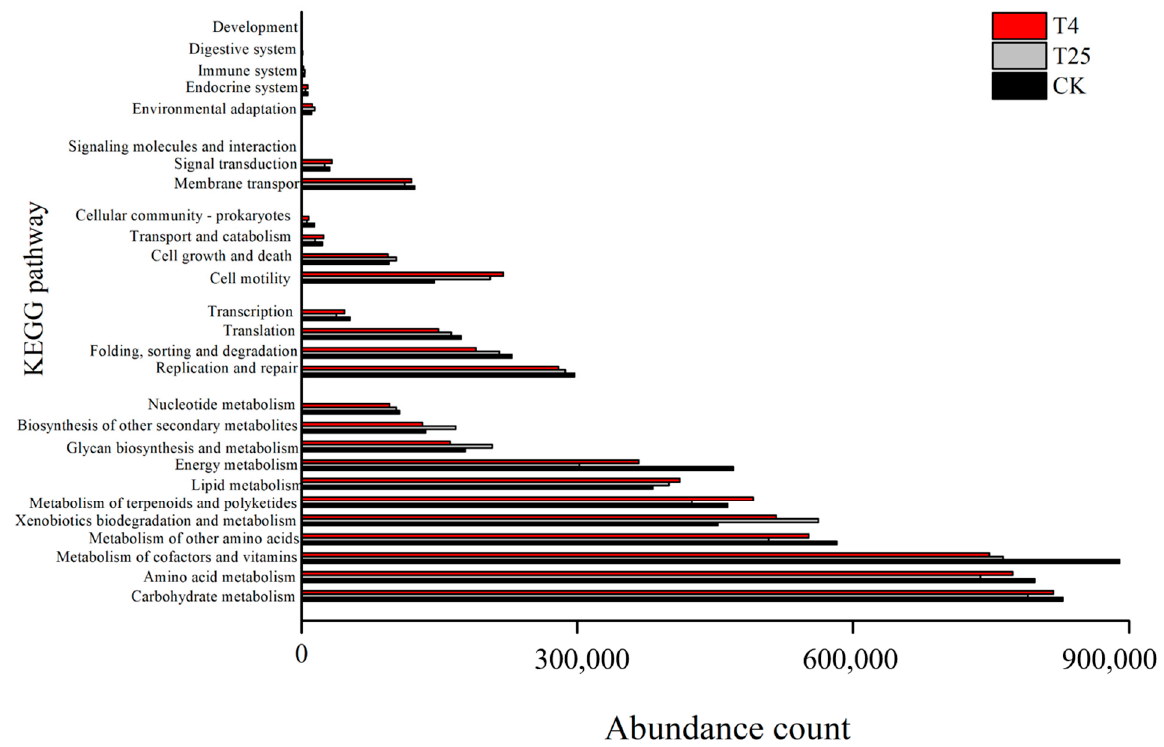
Figure 7. KEGG functional annotation of microbial communities on the blueberry surface.